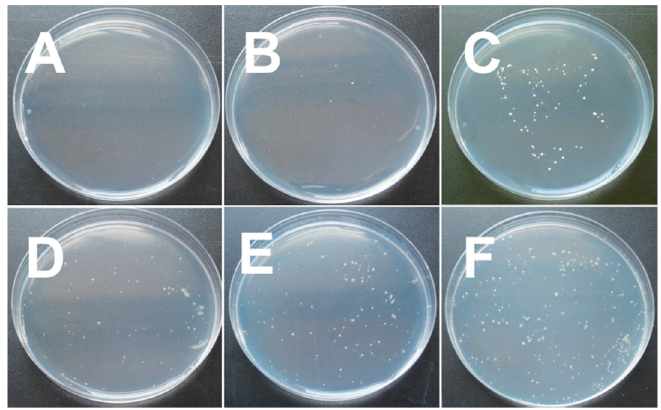
Figure 5. Images of antibacterial efficacy against S. cerevisiae for ( A ) C, ( B ) CB, ( C ) CB-b, ( D ) CB-t, ( E ) CB-bt, and ( F ) Blank (PE film).